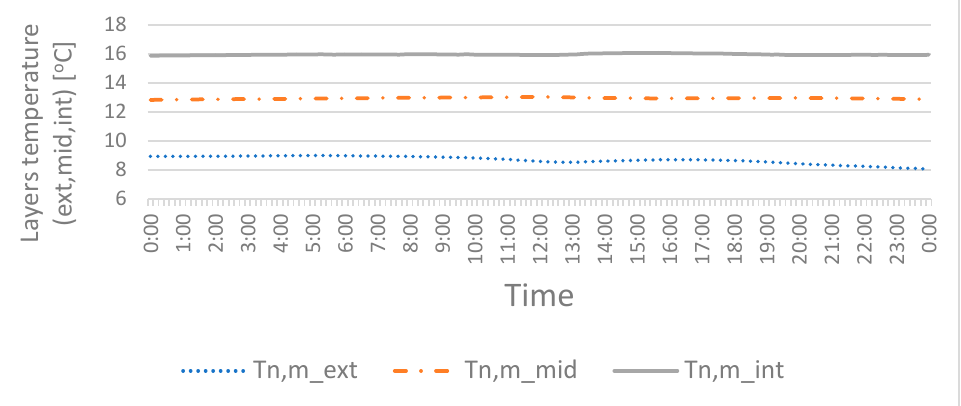
Figure 12. Graph of the average temperature in three layers of the wall on 5 January 2021.